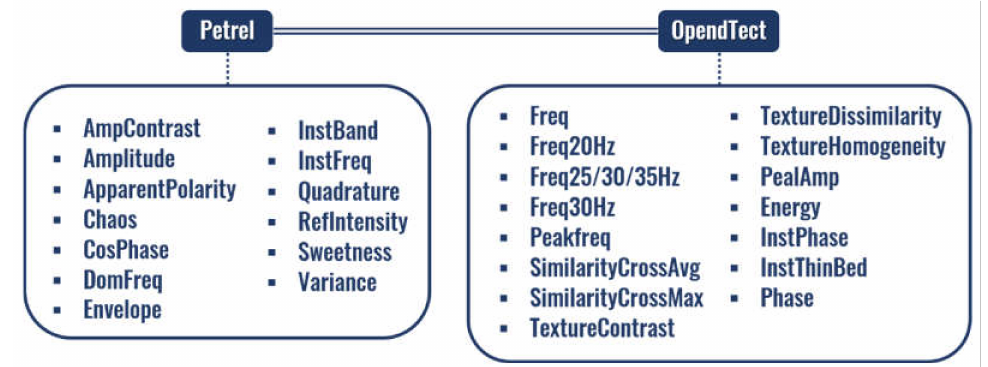
Figure 9. Seismic